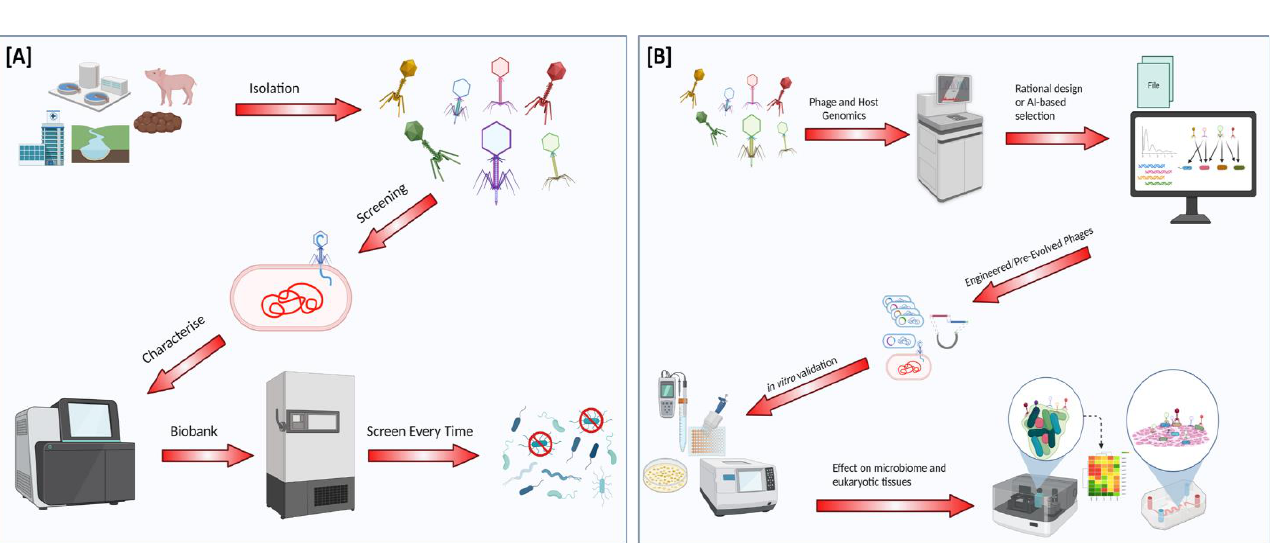
Figure 1. Schematic representation of ( A ) conventional preclinical phage characterisation and ( B ) novel approaches to phage characterisation.